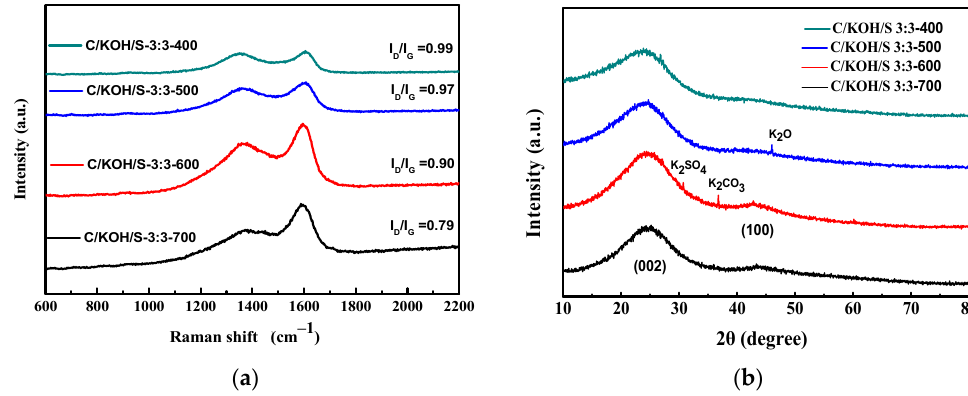
Figure 4. Analyses of Raman spectra ( a ) and XRD ( b ) of the activated carbon materials.